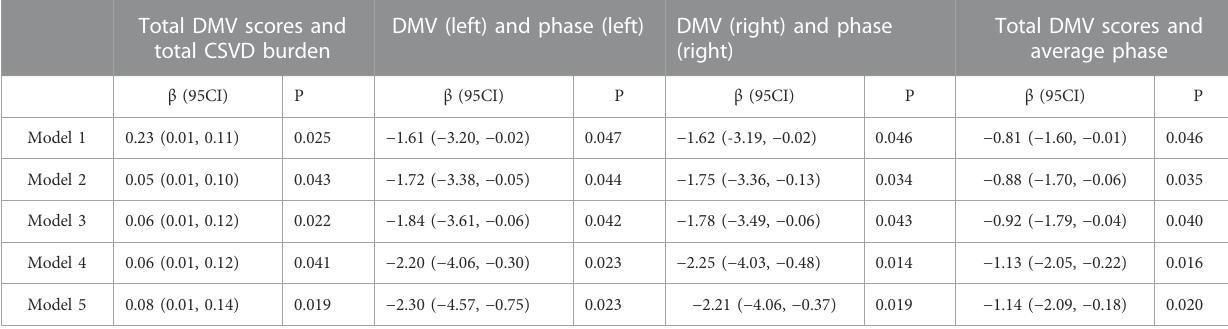
Total DMV scores and average phase